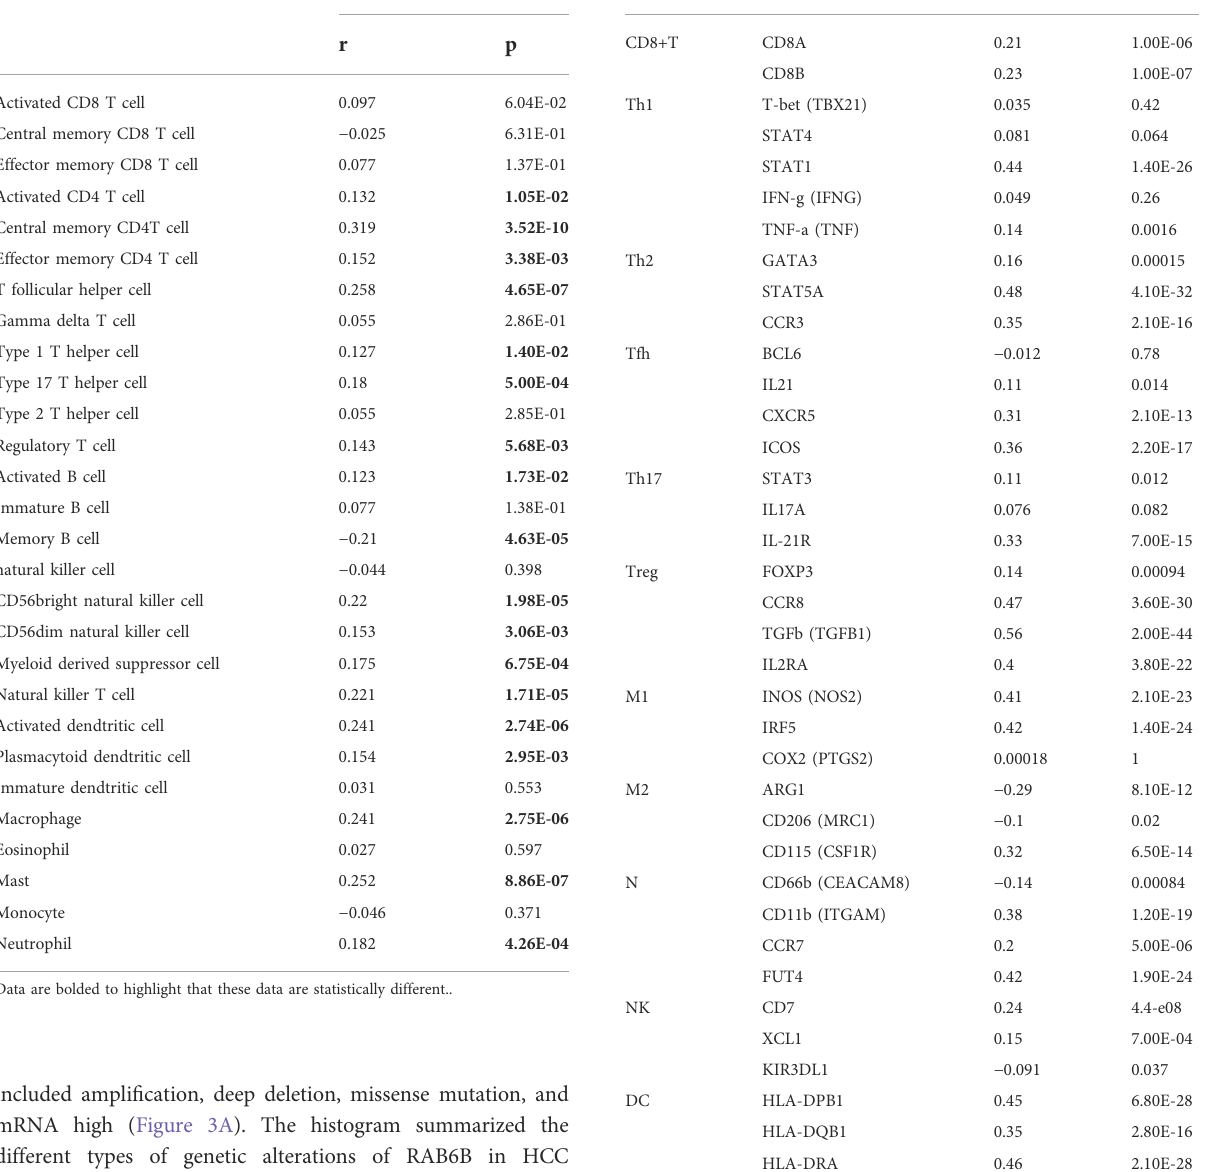
TABLE 3 Correlation analysis between RAB6B expression and immune cell markers in HCC. LIHC